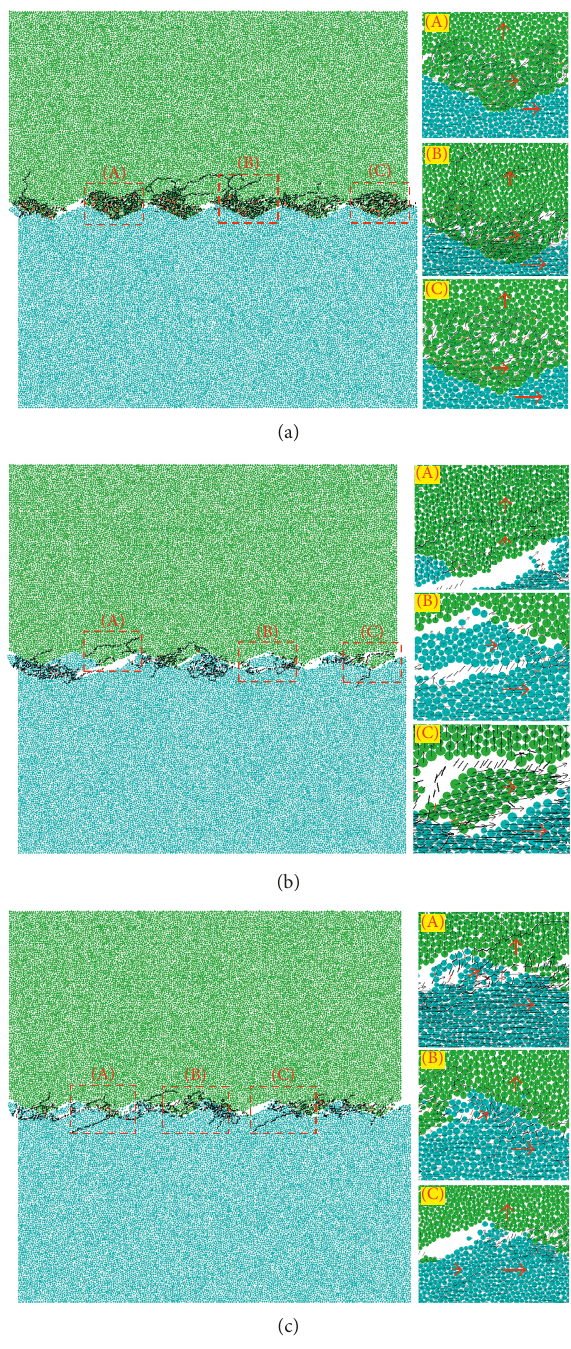
Figure 8: Different kinds of failure modes and distribution of dis- placement field: (a) bond strength ratio of 0.25 and normal stress of 1.0MPa, (b) bond strength ratio of 0.75 and normal stress of 1.0MPa, and (c) bond strength ratio of 1.0 and normal stress of